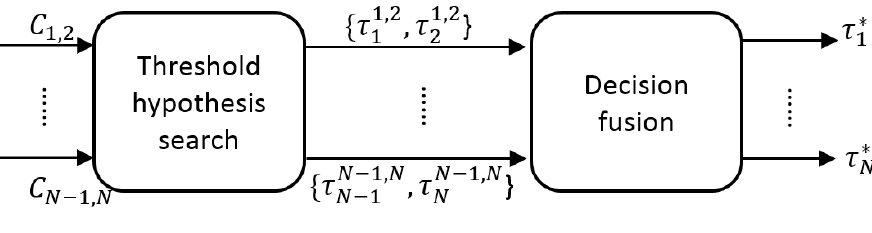
Figure 8. Overview fine